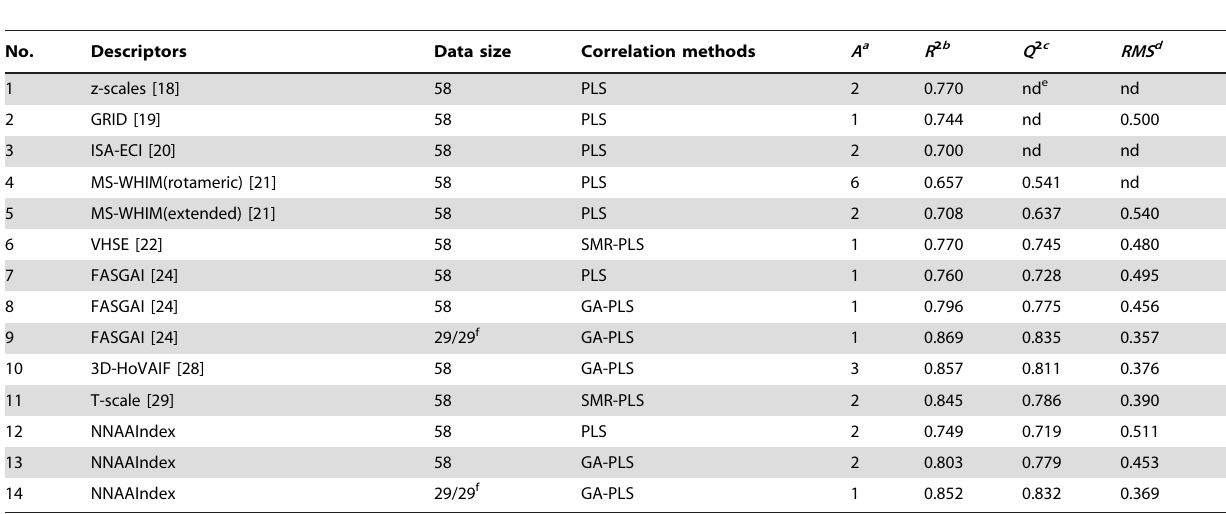
Table 4. The performance comparison among different QSAR models of ACE